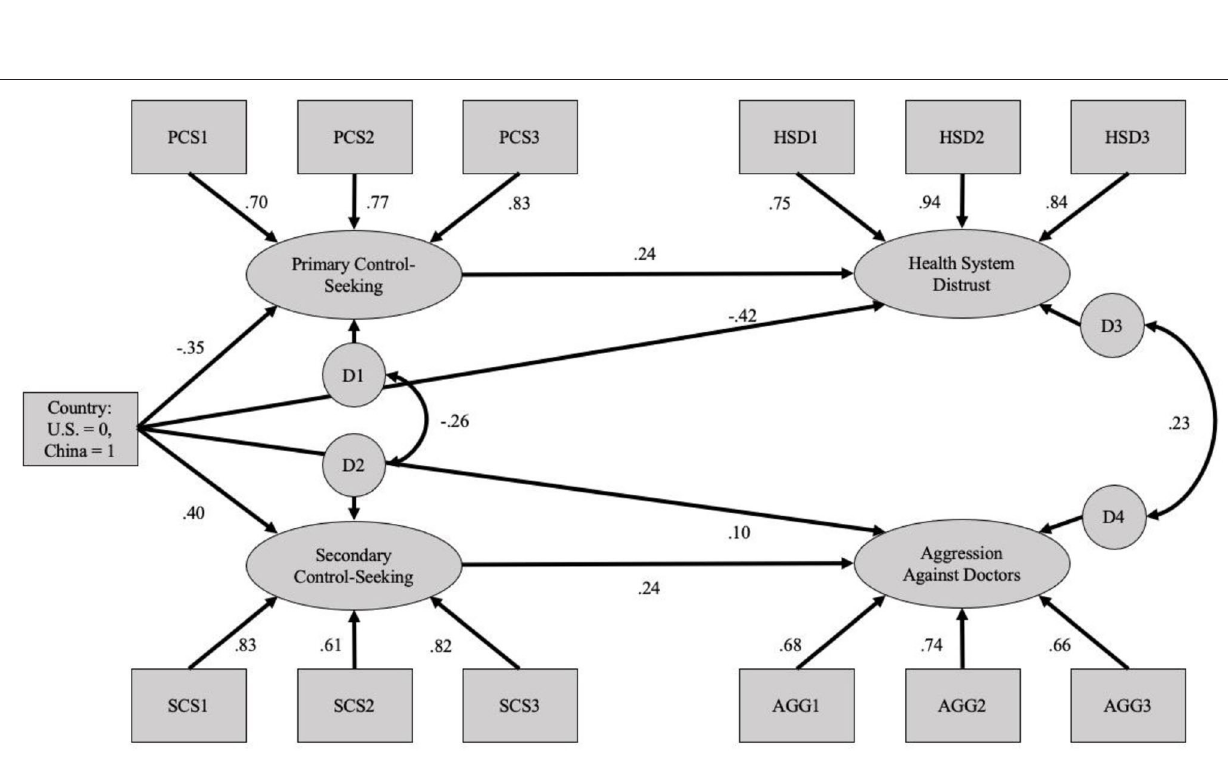
FIGURE 4 | Mediation structural equation model using the COVID-19 Uncertainty Scenarios (Study